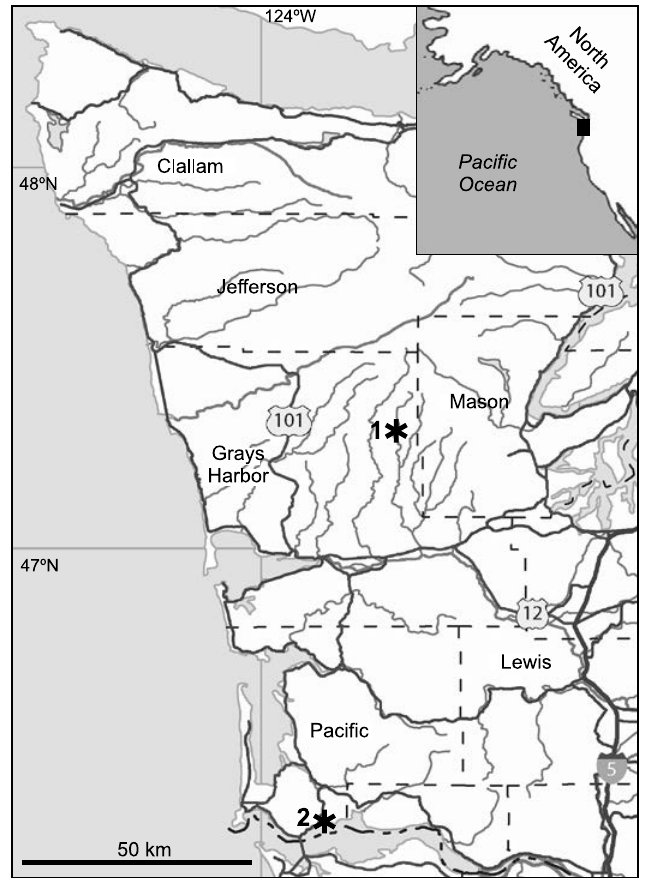
Fig. 1. Map showing location of the studied localities in North America (inset) and western Washington State, USA. 1, the new West Fork Satsop seep deposit; 2, Knappton, the type locality of Squiresica knapptonensis